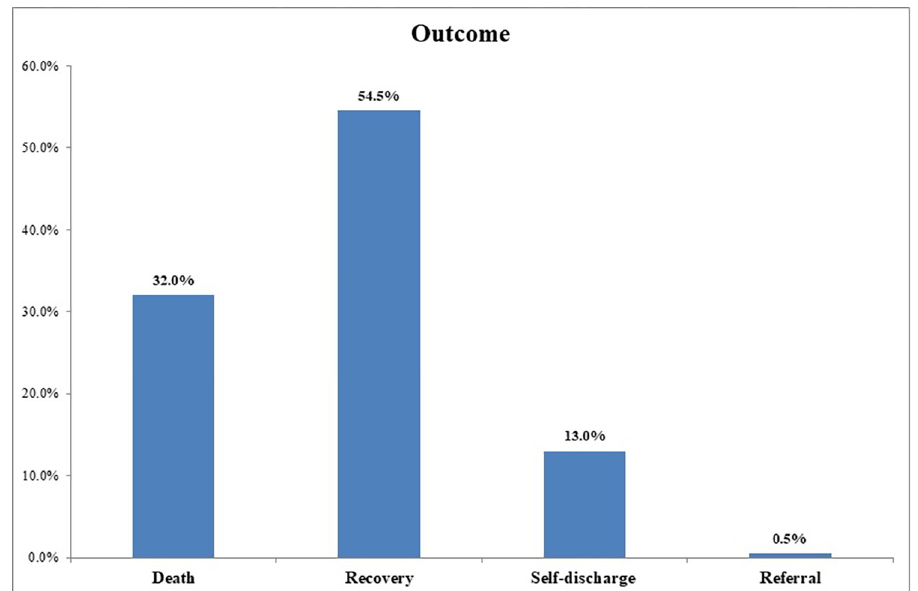
Fig 2. The outcome of asphyxiated newborns admitted to the NICU of DCSH, Amhara region, Northeast Ethiopia (N = 378).